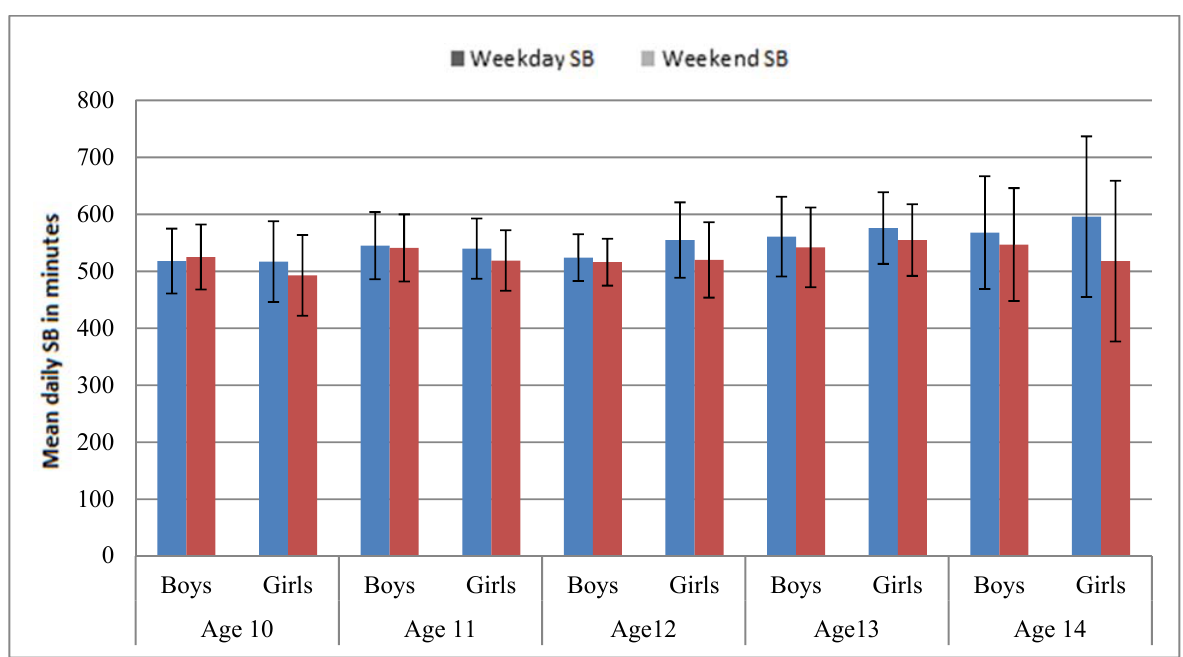
Figure 2. Mean daily moderate to vigorous physical activity on weekdays and weekend days.